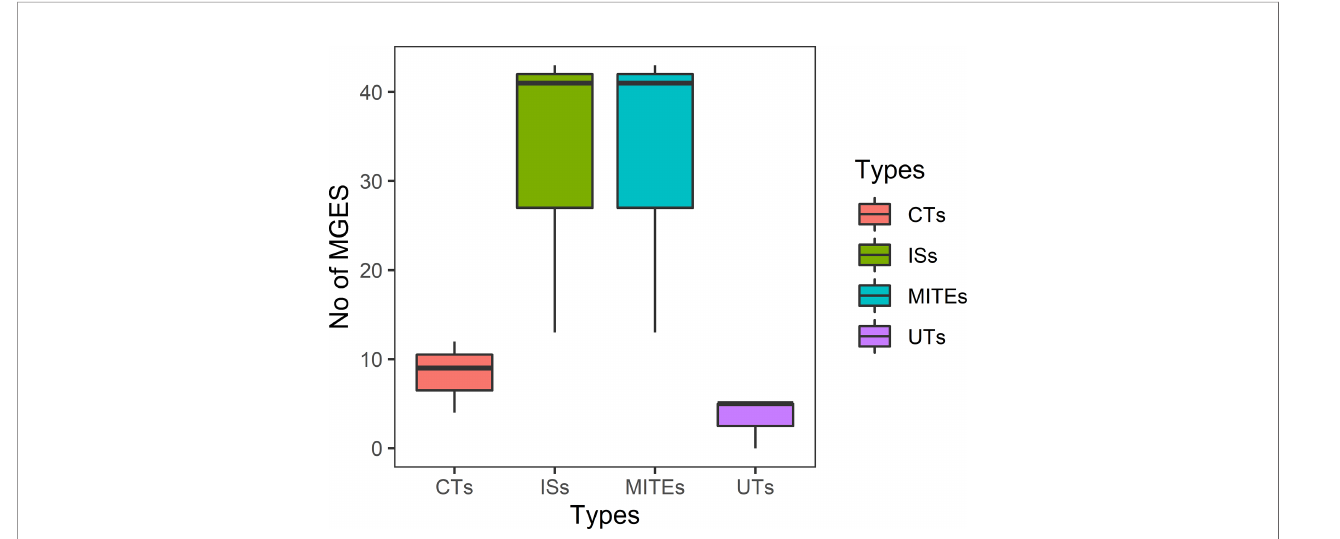
FIGURE 4 | Total number of predicted MGEs in ESBL-EC isolates from all sources.